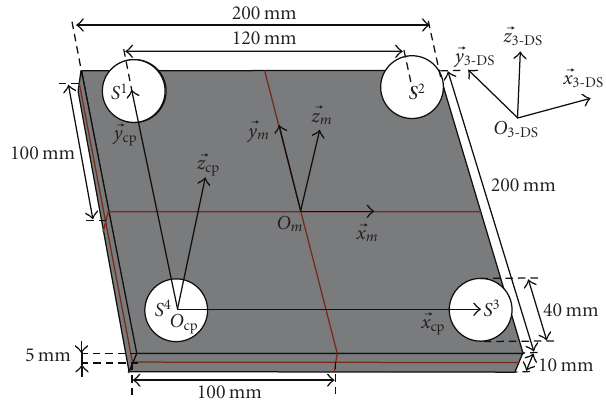
Figure 3: Calibration piece dimensions and coordinate